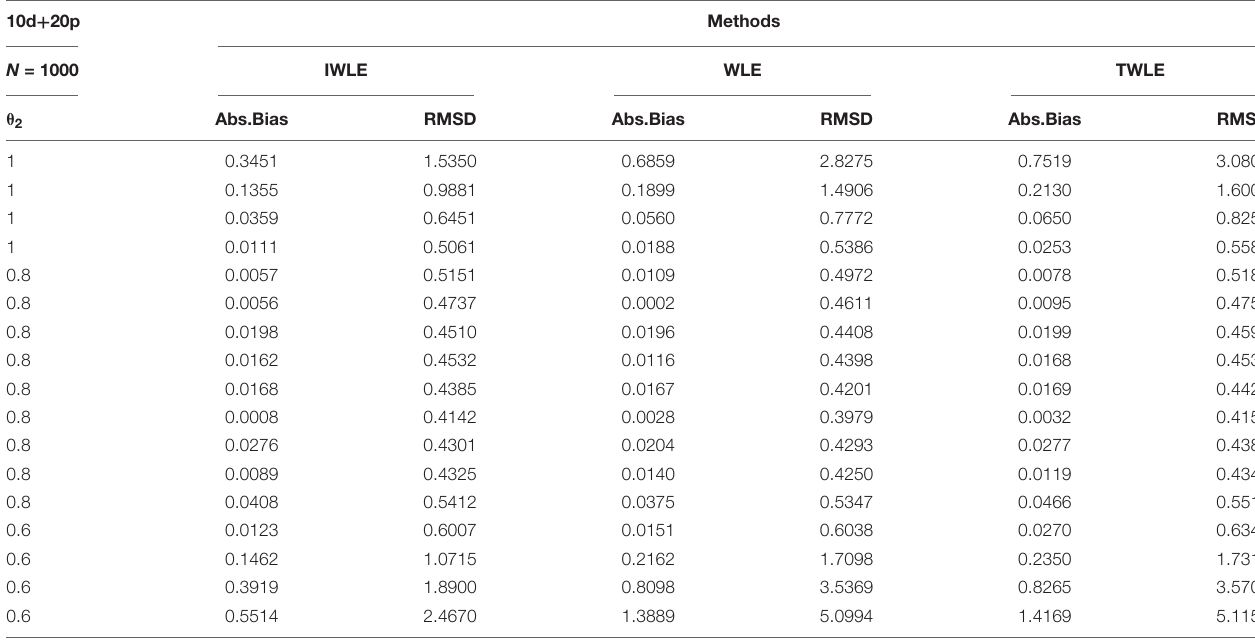
TABLE 7 | Absolute bias and root mean squared difference for WLE, TWLE, and IWLE at 3 different levels of growth for 10 d +